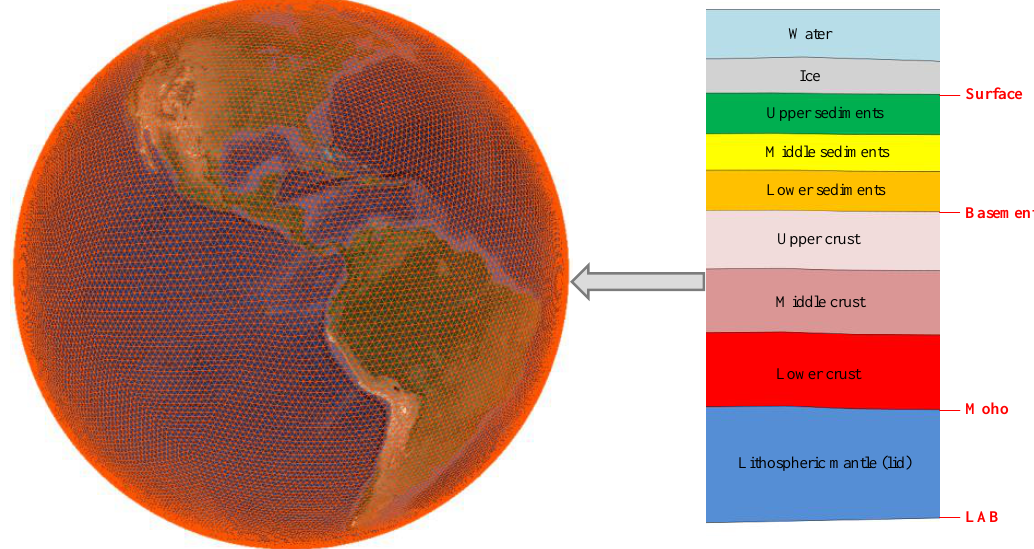
Figure 1. Lithospheric structure representation implemented in the LITHO1.0 model. The lithosphere is parametrized laterally by 40,962 tessellated nodes and 81,920 triangles at approximately 1° resolution, and vertically as nine geophysically-identified sublayers.